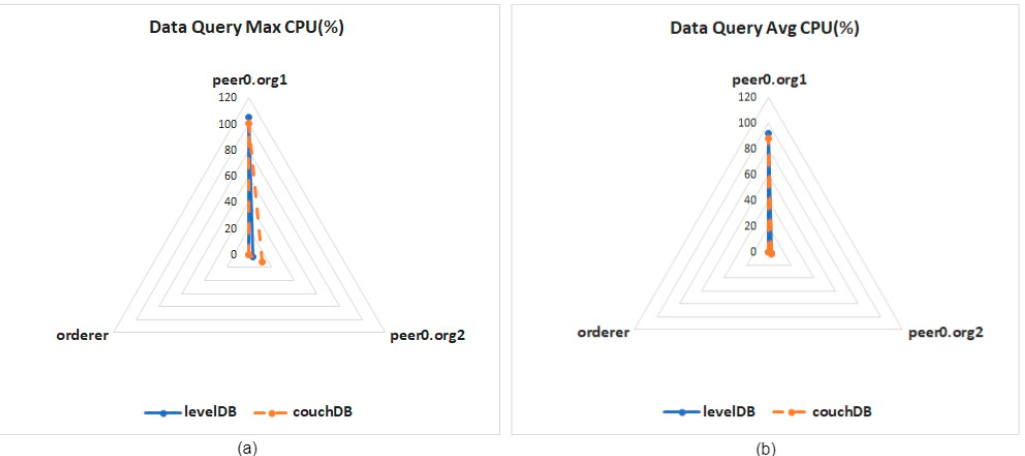
Figure 13. CPU usage for single data query: ( a ) maximum CPU usage, ( b ) average CPU usage.